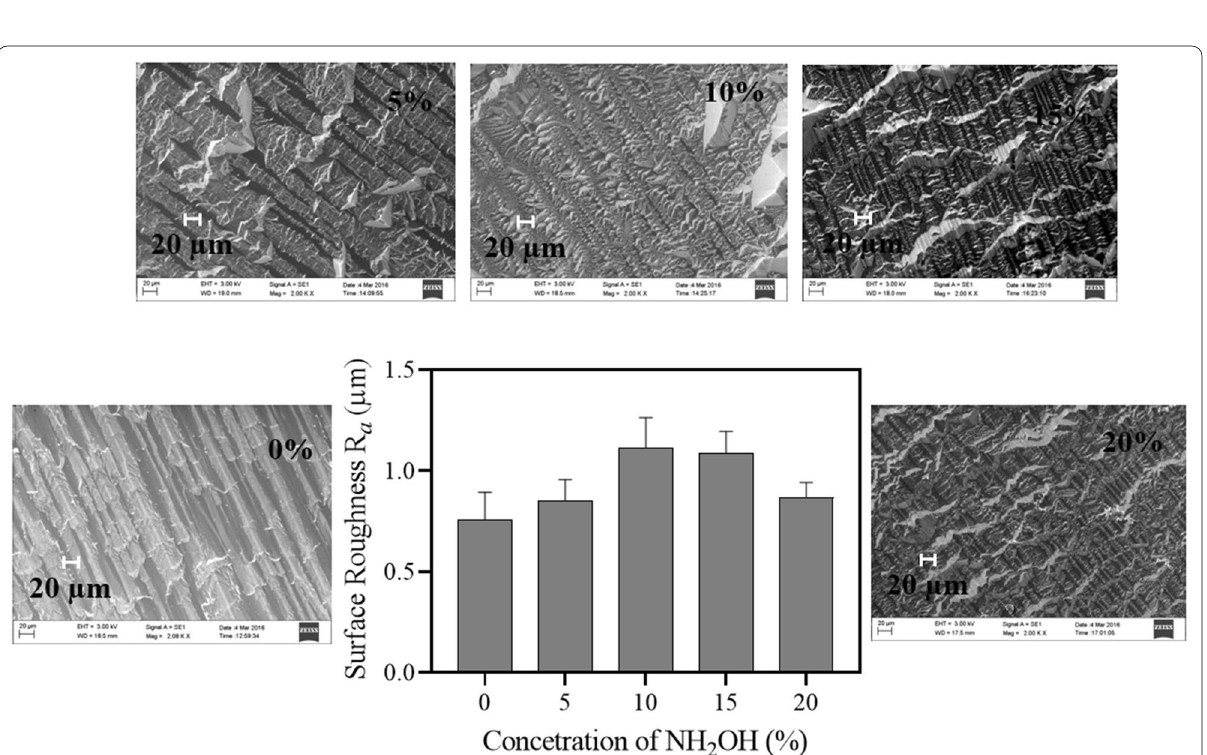
Fig. 42 Etched surface roughness (Ra) and corresponding surface morphologies of Si{100} in pure and different concentrations of NH 2 OH added 20 wt% KOH at 75 1 °C [51] ±